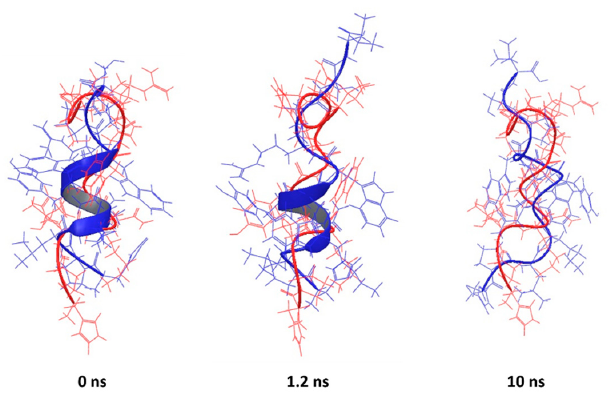
Figure 7. Backbone superposition of PDB entry 2JQ2 (red) and simulated conformations at 0, 1.2 and 10 ns (blue). NMR experiments show that 2JQ2 assumes relaxed coiled conformations, whilst the PEP-FOLD prediction provides a partially α -helical structure, which progressively deteriorates over the simulation time.